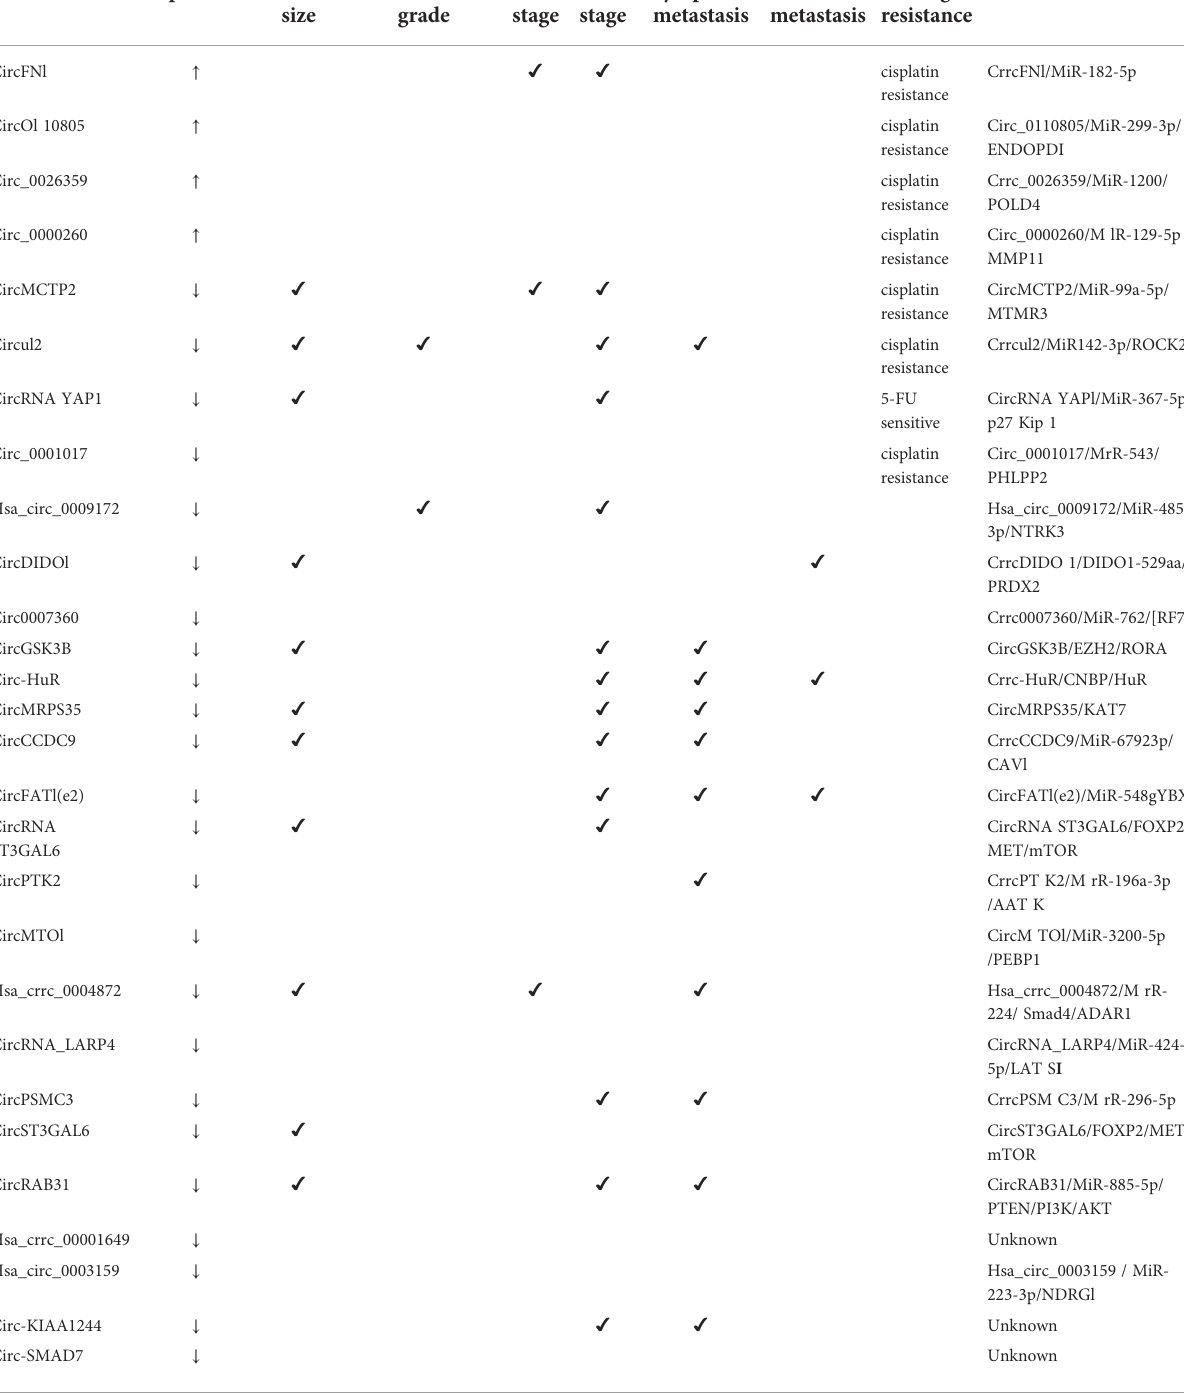
expression of ebv-circLMP2A in 69 EBVa GC patients. It is found that high expression of ebv-circLMP2A is signi fi cantly associated with lymph node metastasis, distant metastasis and TNM advanced stage (55). The expression level of circDLST